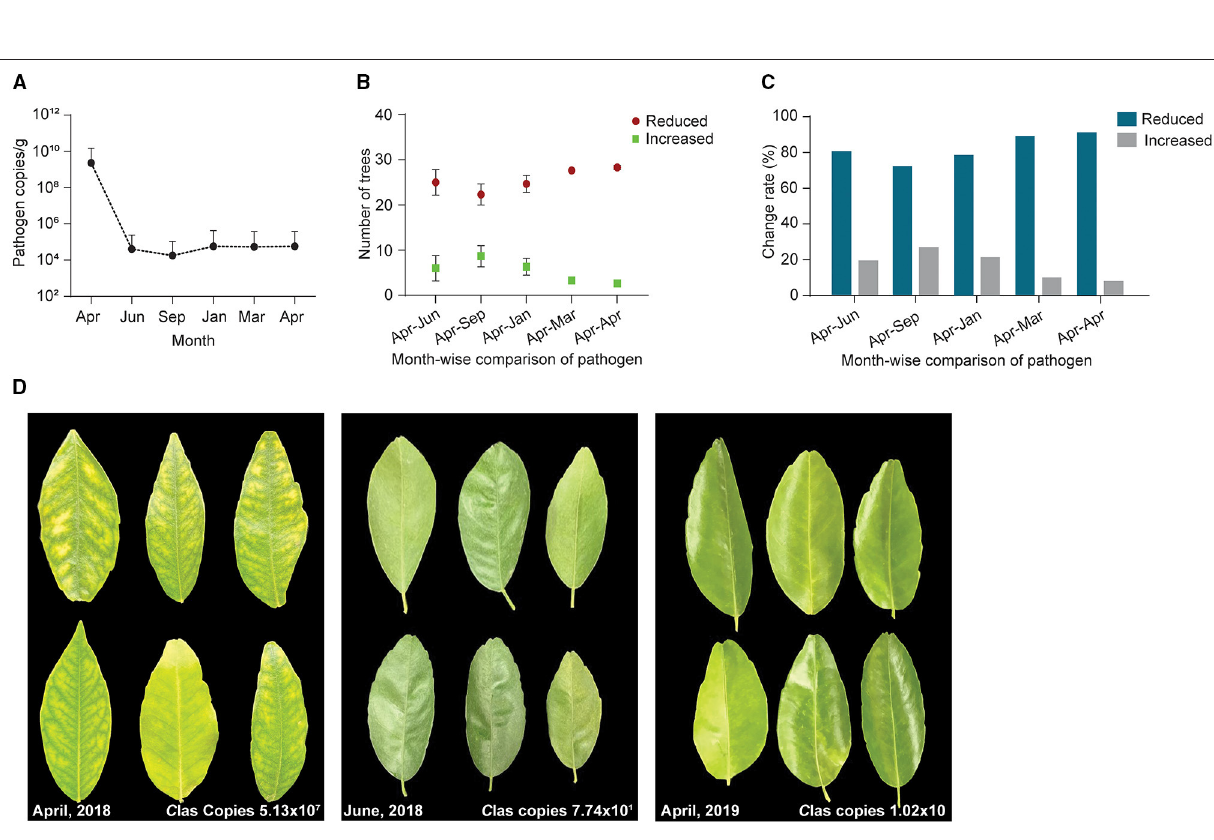
was labeled with RFP that can express mKate2 gene. In light of our finding, CLSM visualization clearly showed successful colonization in the phloem of citrus leaves, which may open more